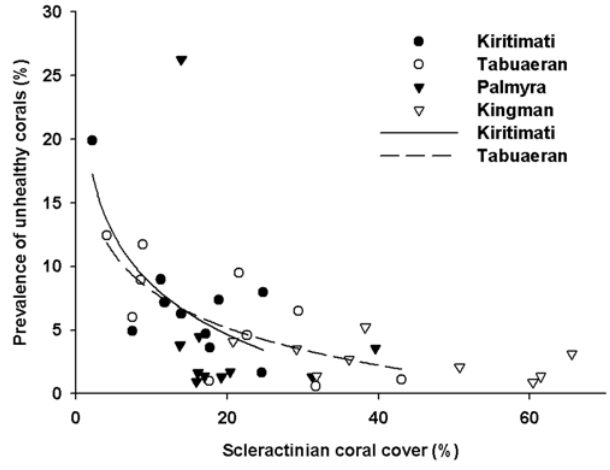
Figure 5. Relationships recorded between microbes and virus- like particle numbers on the Northern Line Islands. Kingman (dotted line) r 2 = 0.807, P , 0.0001; Palmyra r 2 = 0.039, P= 0.414; Tabuaeran (dashed line) r 2 =0.324, P=0.006; Kiritimati (solid line) r 2 =0.706, P , 0.0001.